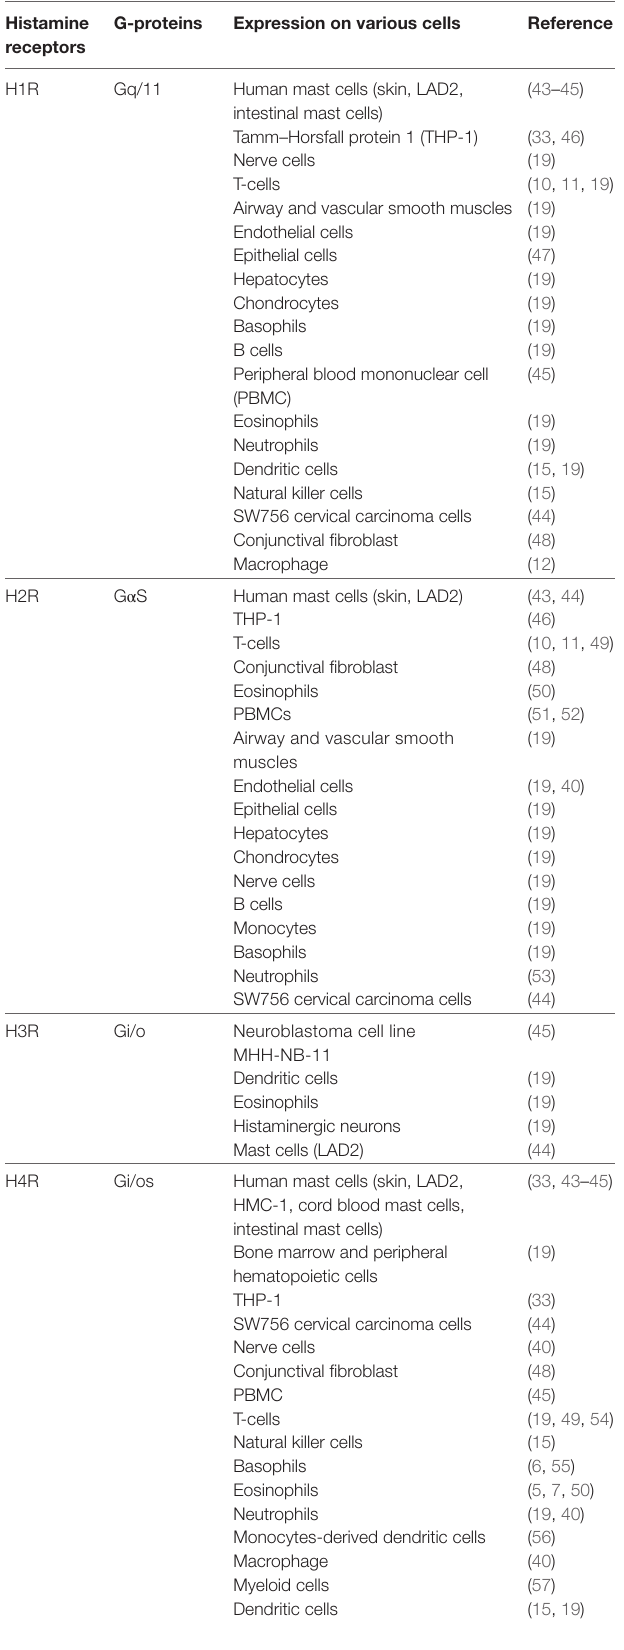
TAbLe 1 | Expression of different histamine receptors on various cells. Histamine receptors